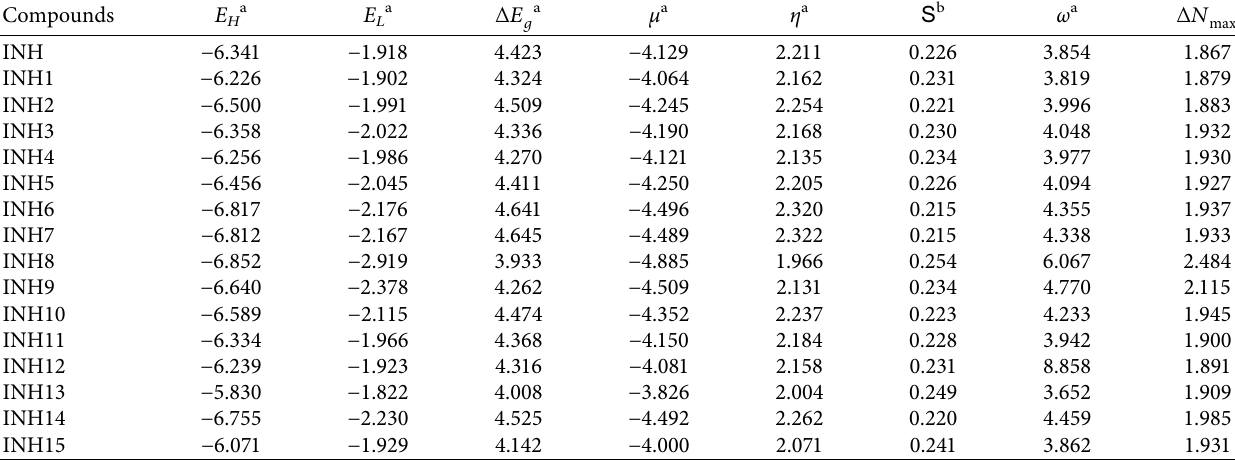
Table 1: Electronic parameters of N-(4-methoxybenzylidene) isonicotinohydrazone and its derivatives calculated at B3LYP-D/6-311G (d,p) level of theory in the gaseous